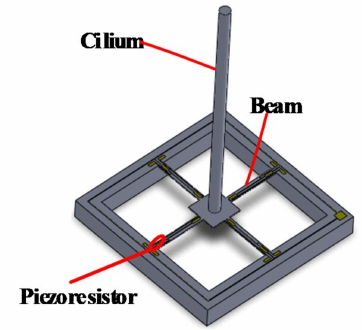
Figure 1. The sensing microstructure of the MEMS vector